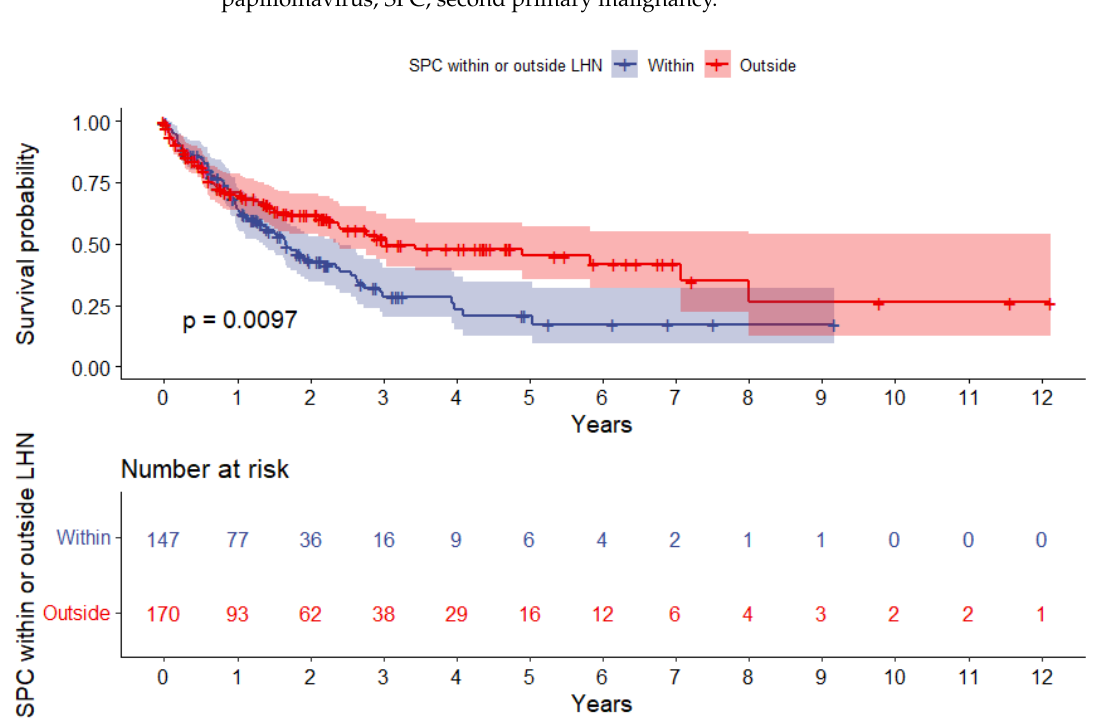
Figure 2. Kaplan–Meier plot depicting overall survival after SPC stratified on HPV status. The red line shows patients with HPV+ OPSCC, and the blue line shows patients with HPV- OPSCC. The difference is significant ( p = 0.003), tested with the log-rank method. Abbreviation: HPV, human papillomavirus; SPC, second primary malignancy.